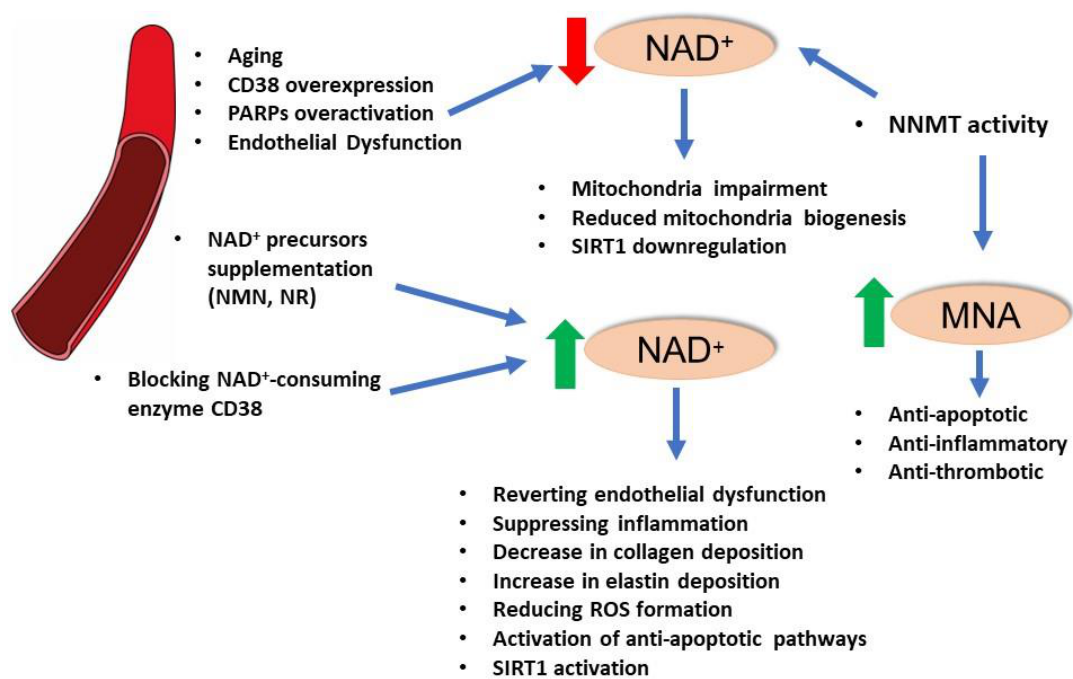
Figure 2. Impact of NAD + homeostasis and major NAD + -consuming enzymes on vascular